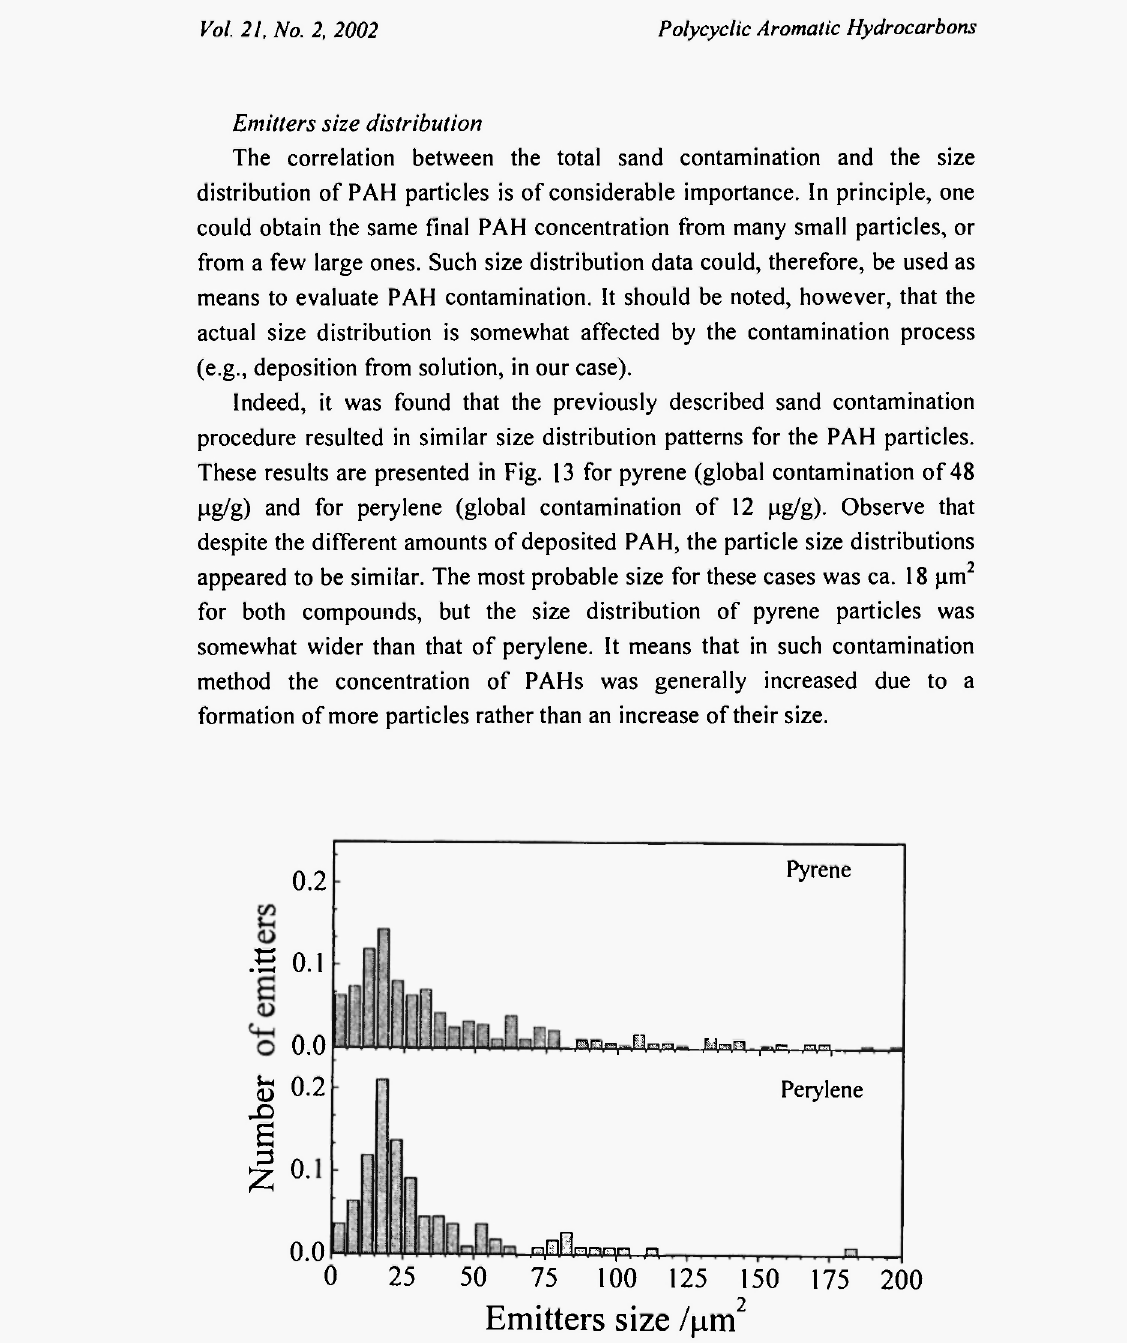
Fig. 13: Emitter size distribution of perylene (bottom) and pyrene (top), normalized and truncated at 200 μπι 2